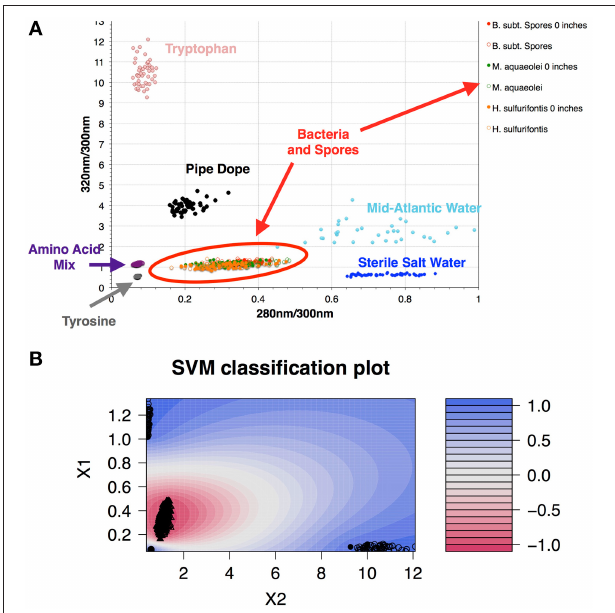
FIGURE 2 | A library of organics and microbes was used to classify data collected at Hole 395A. The database was classified in a binary form: “microbe” and “organic.” (A) Scatter plot of the standards used for classifying the data collected with DEBI-t. Because the instrument had a long depth of focus, the data was collected at two distances: just in front of the turning mirror (0 inches); and 10 inches from the turning mirror. Fluorescence spectra from all bacterial standards collected at both distances clustered in the same location (red oval); (B) SVM contour plot with the fitted decision values using the library. A semi-supervised Laplacian kernel was used to train the SVM. The scale (right) shows the decision boundary values for the two sets, with − 1 denoting the “most microbe-like,” and + 1 denoting the “most organic-like,” or “least